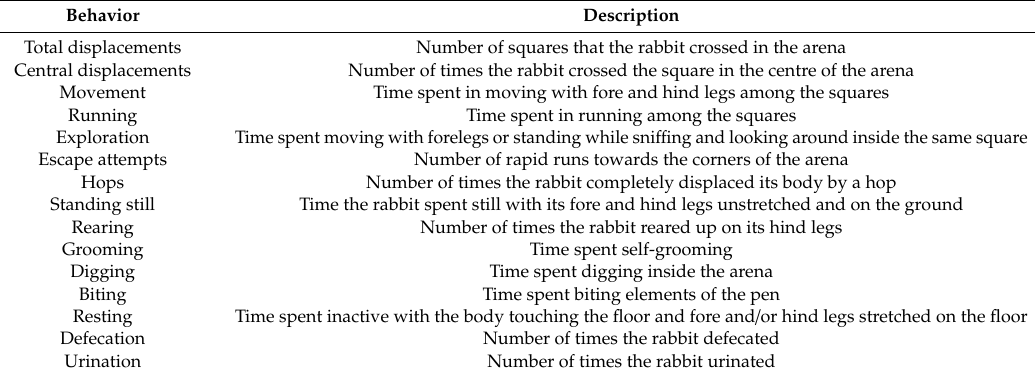
Table 2. Behaviors evaluated during the open-field test